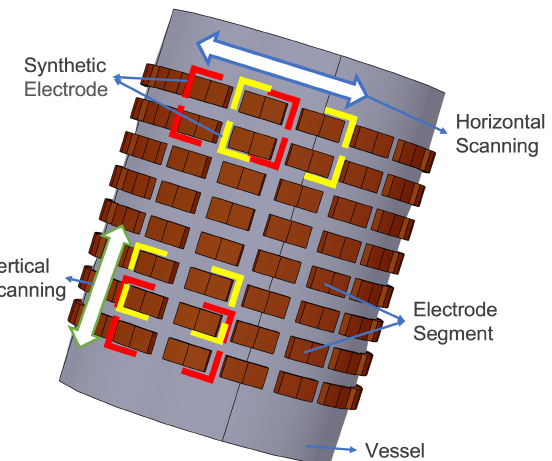
Figure 9. Illustration of an adaptive ECVT sensor. The segments in brown constitute the physical electrodes surrounding the VoI. The red and yellow indications are synthetic electrodes formed by the electronic combination of individual segments (four segments in this example). Synthetic electrodes can be used to attain the minimum required electrode area for a given SNR requirement while enabling additional measurement data. Importantly, they enable fine-stepped scanning (as indicated by the arrows) to provide better sensing